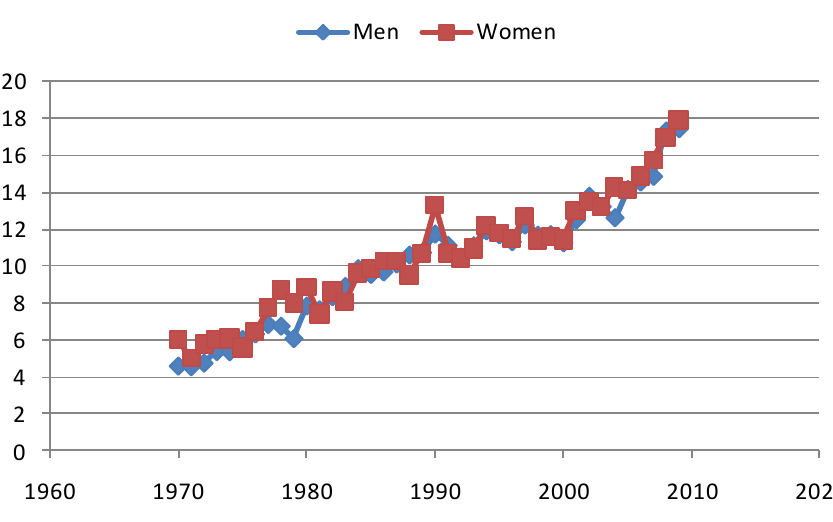
Figure 9. Age-standardized rate of melanoma in Sweden (world standard).